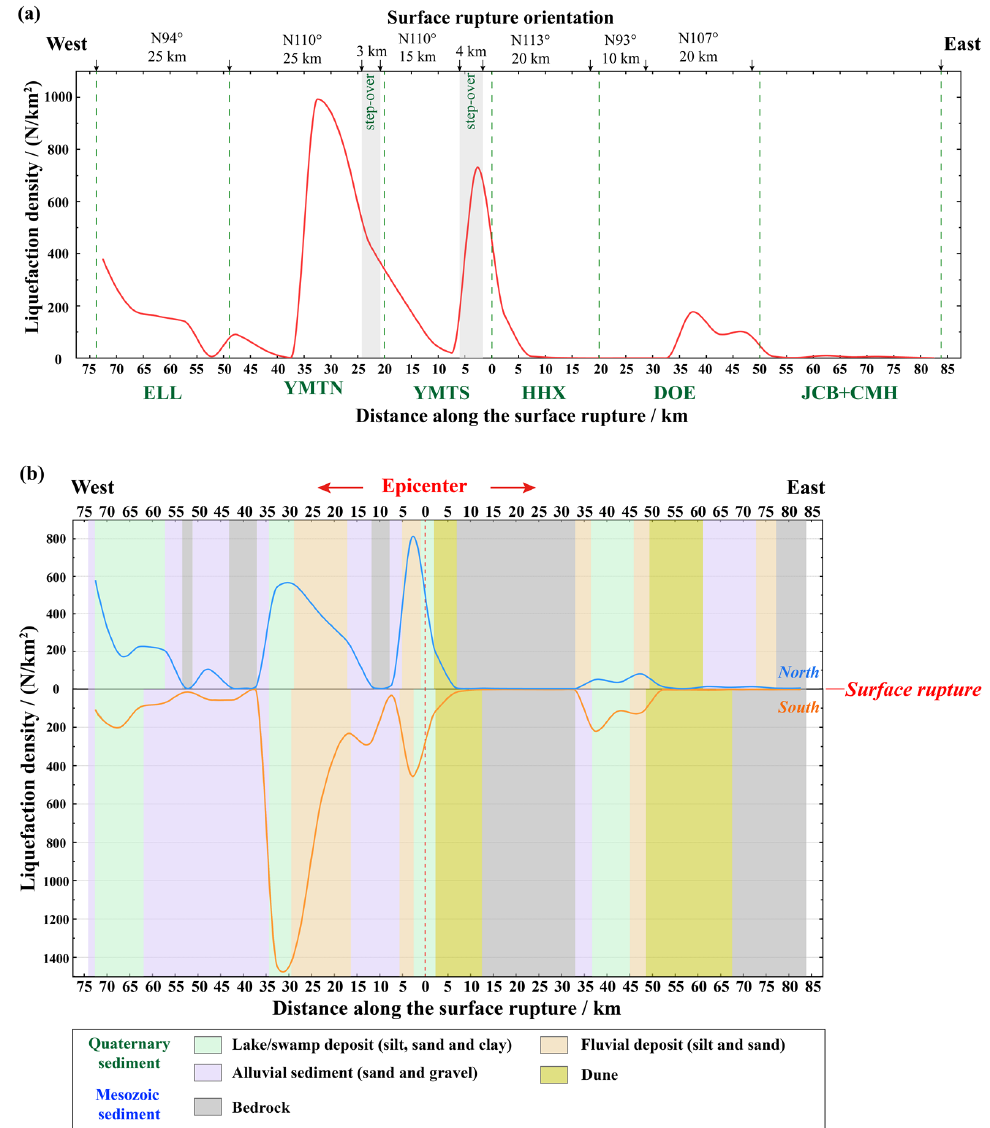
Figure 6. ( a ) Variation of soil liquefaction density along the surface rupture. The orientation informa- tion of surface ruptures is obtained from Liu-Zeng et al. [1]. ( b ) Difference of soil liquefaction density between the north and south sides of the surfae